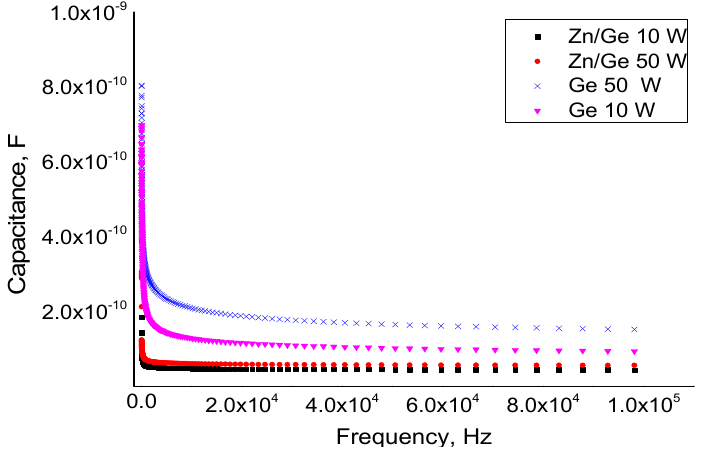
Figure 3. Capacitance measured for pristine and composites plasma geranium thin films fabricated at 10 W and 50 W as a function of frequency in the range of 10–100 kHz.